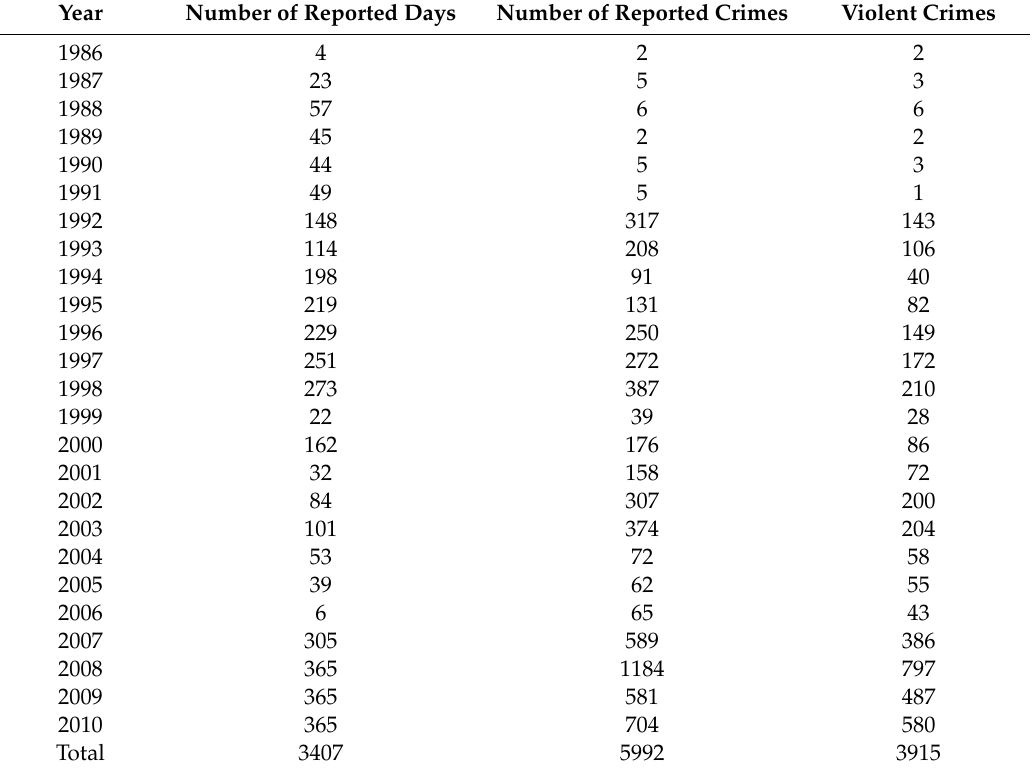
Table 1. A description of the archives and the number of reports on violent crime they contained. Number of Reported Days Number of Reported Crimes Violent